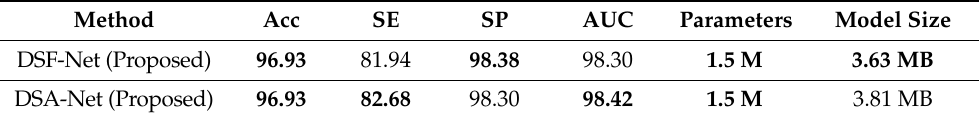
Table 3. Ablation study of the proposed DSF-Net and DSA-Net.